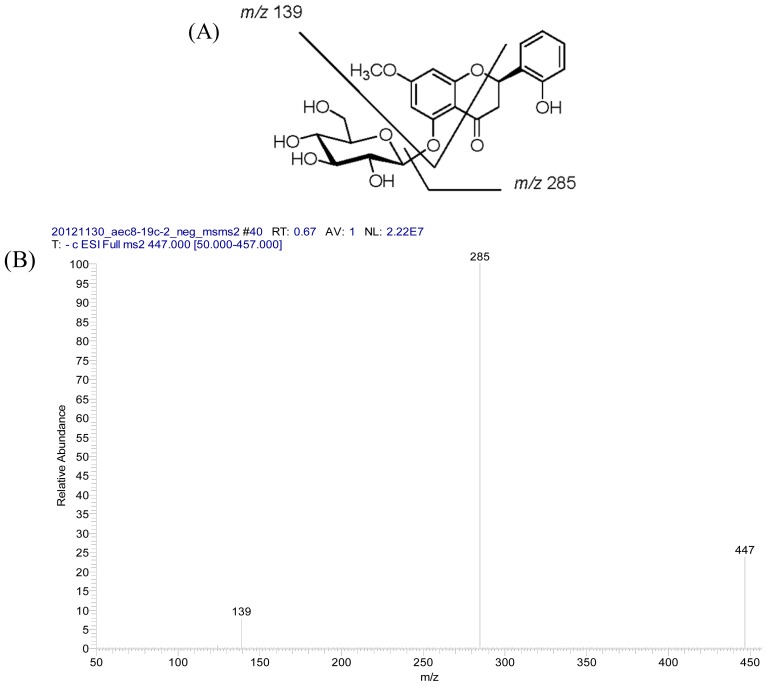
(A) Structure of 2 and main fragments under LC/MS/MS (negative ESI); (B) LC/MS/MS spectrum.